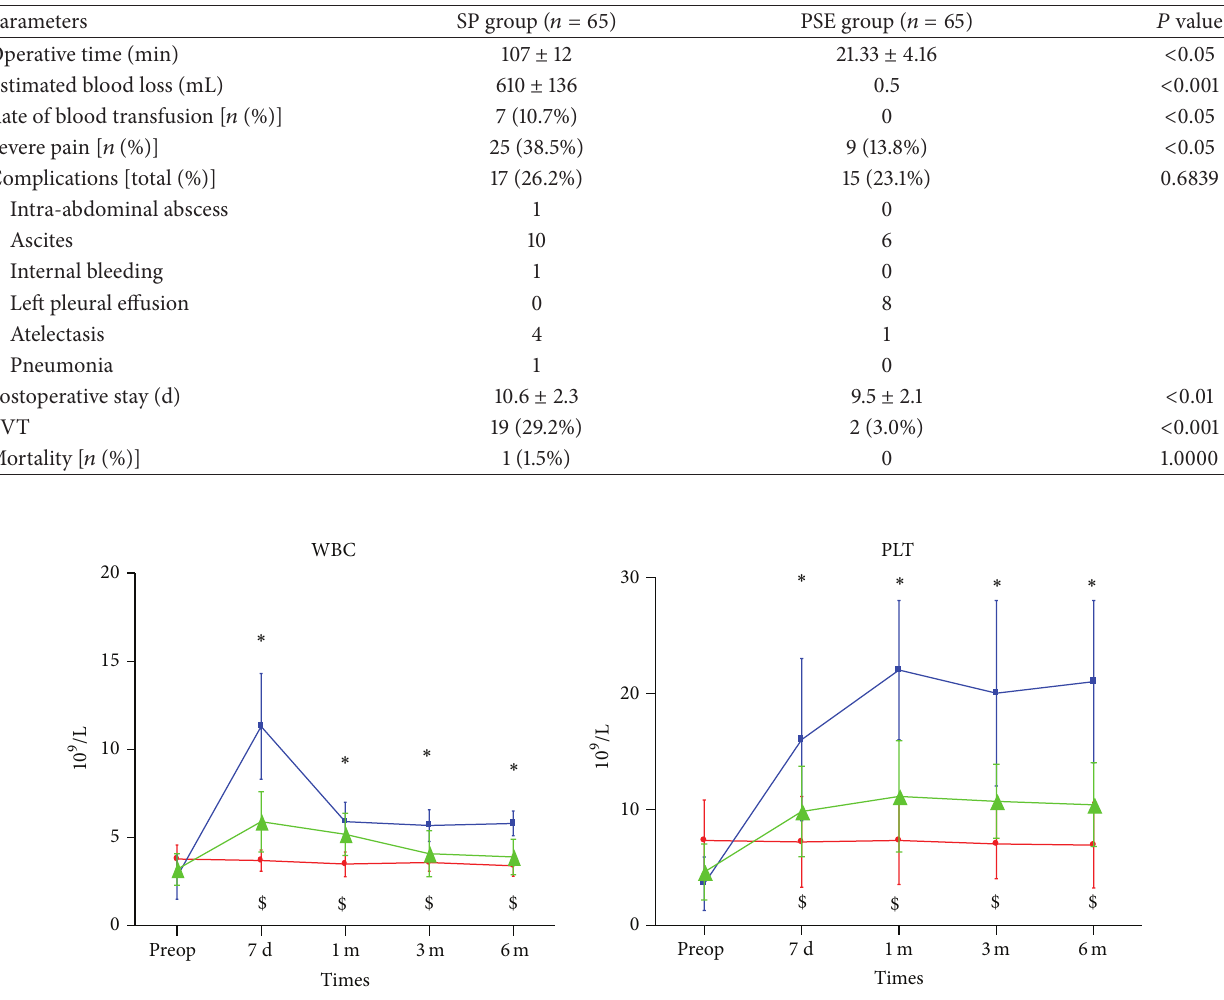
Table 2: Intraoperative and postoperative results.